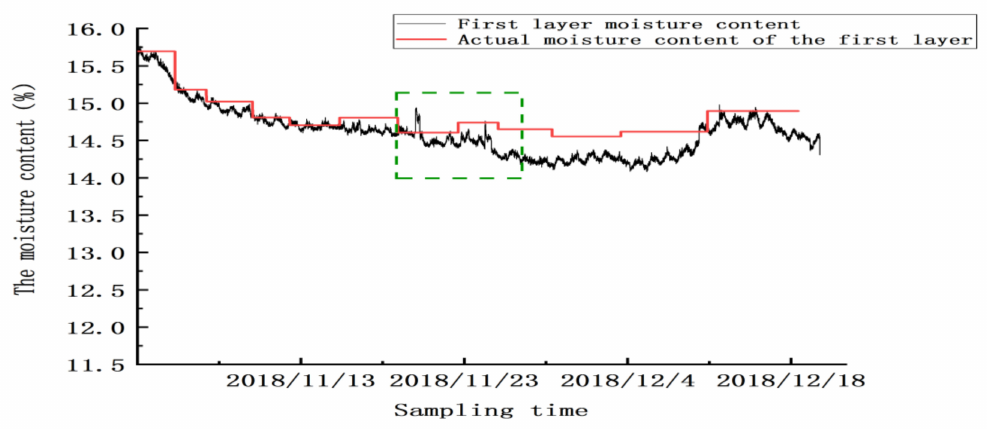
Figure 22. The moisture values of the grain in the first layer. Between 20 and 24 November, there were two abnormal peaks, as shown in the green box in the figure; the abnormality in this area was due to the abnormal test results caused by mechanical ventilation. Twenty-four hours after ventilation, the sensor gradually reached a stable state. From 25 November to 20 December, the sensor’s detection error was ± 0.32%, and the mean absolute error for detecting moisture in this layer was ± 0.2625% (excluding the abnormal zone value). Similarly, as shown in Figures 23–25, abnormal peaks appeared, as highlighted by the green squares, on the second, third, and fourth floors, respectively.